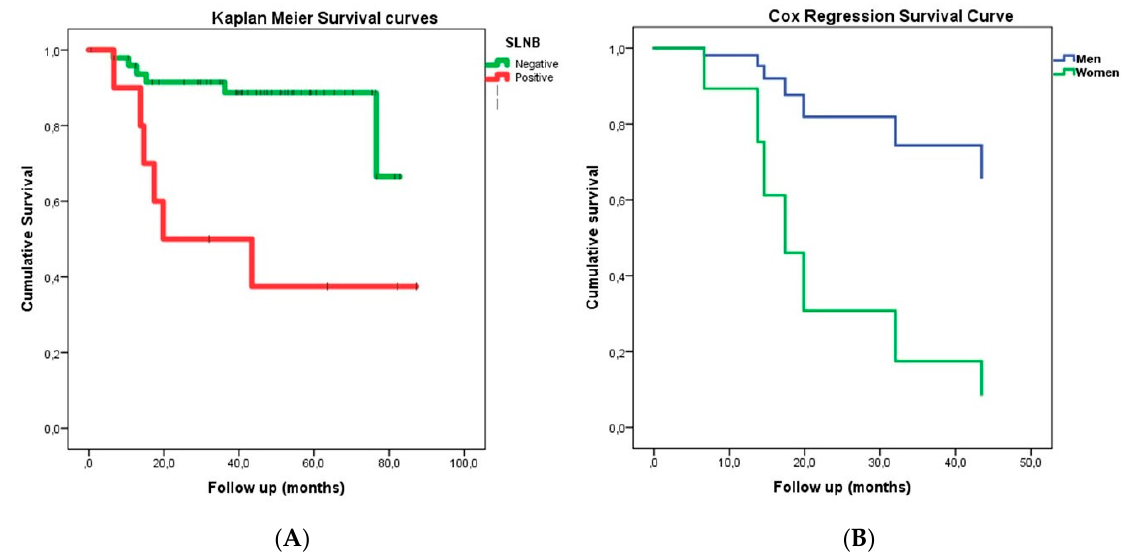
Figure 1. Kaplan–Meier ( A ) and Cox ( B ) survival curves. (SLNB: Sentinel lymph node biopsy technique). By using logistic regression, we determined that SN+ patients presented an OR = 11.00 (CI95% 2.393–50.589, p = 0.002) for cancer-related mortality. When we adjusted the regression model to a location different to the tongue and stage T2, the OR for mortality in SN+ patients was 28.75 (CI95% 2.71–305.62, p = 0.005) (Table 3). Table 3. A univariate logistic regression analysis was performed to determine the univariate OR for death. The statistical analysis of the adjusted OR was performed using gradual multivariate logistic regression adjusted for SLN, location and TNM. SLN: sentinel lymph node; OR: Odds Ratio. Death Covariate Univariate OR (95% CI) p Value Adjusted OR (95% CI) p Value SLN (Sentinel Lymph Node) Positive vs. Negative 11.00 (2.39–50.59) 0.002 28.75 (2.71–305.62) 0.005 Location Other vs. Tongue 4.23 (0.84–21.40) TNM T2 vs. T1 In terms of the diagnostic performance of the SN test, based on TVP = 10, TVN = 42, TFP = 0 and TFN = 8, 55% sensitivity, 100% specificity, 100% PPV and 84% NPV were obtained. The analysis using ROC curves revealed an AUC = 0.671 (CI95% 0.492–0.850, p = 0.046) (Figure 2).